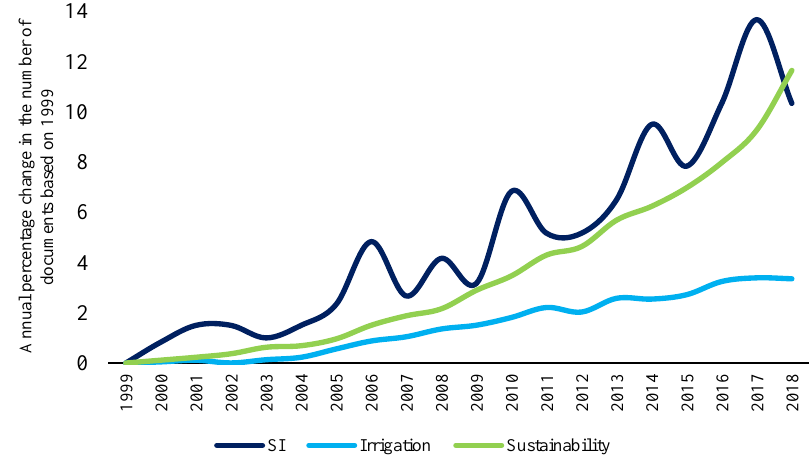
Figure 2. Comparative trends in irrigation, sustainability, and SI research.